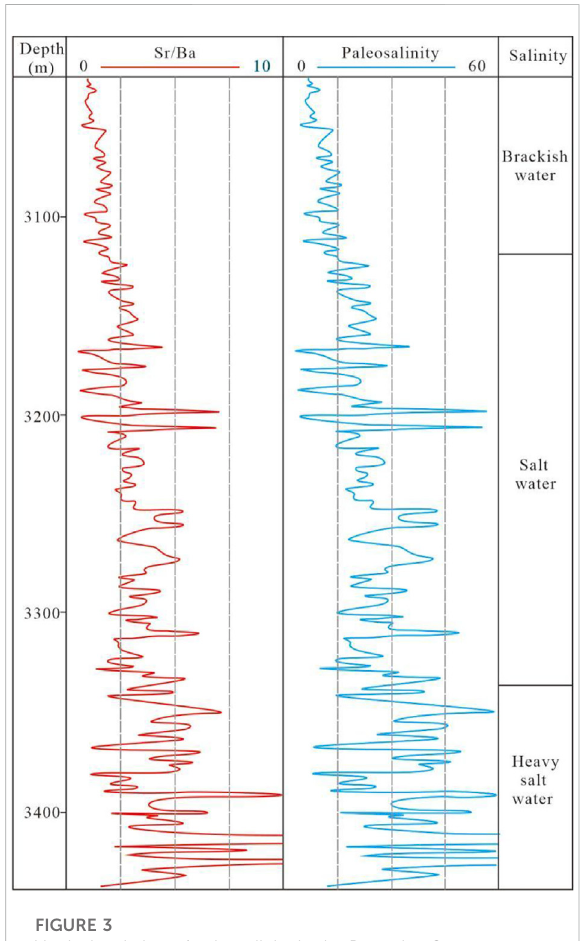
FIGURE 3 Vertical variation of paleosalinity in the Dongying